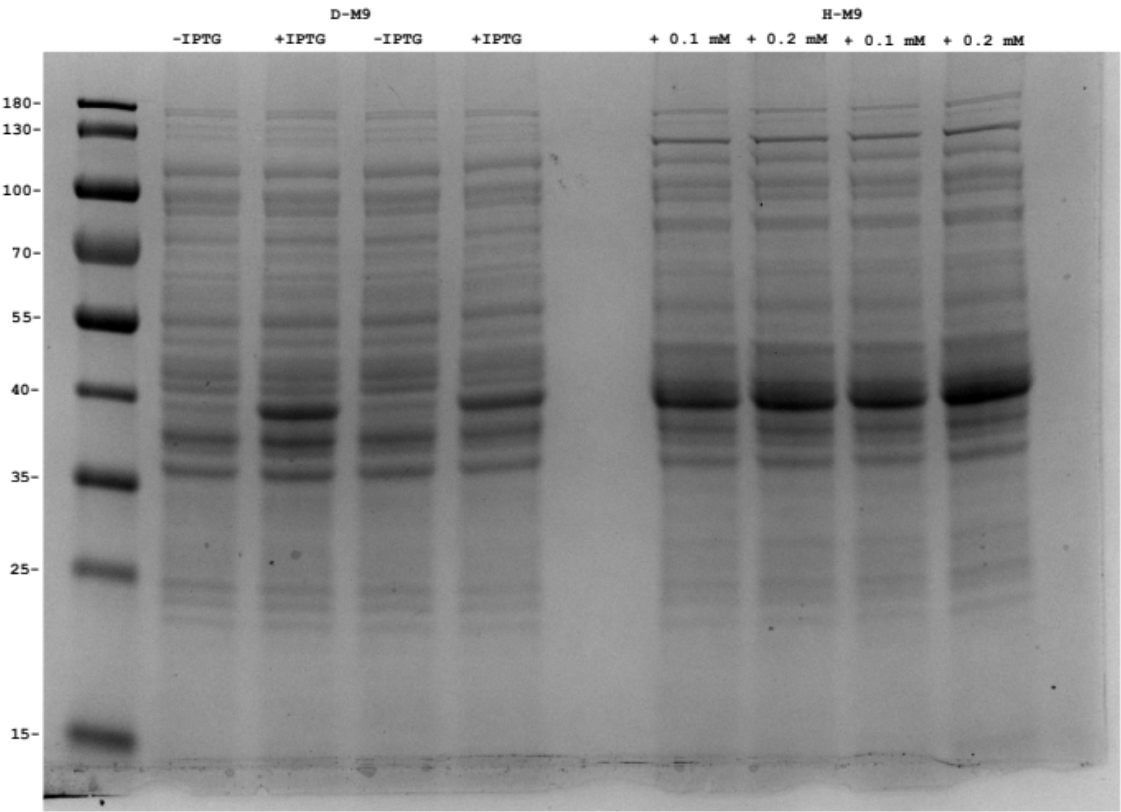
Figure 5. SDS-PAGE analysis of OmpF production. Whole cell fraction of E. coli DAP1(DE3) ( ∆ ompF ) expressing ompF cultured at 37 ◦ C in D-M9 and H-M9. Two different concentrations (0.1 or 0.2 mM) of the inducer IPTG was used in H-M9 media. For the D-M9 media 0.1 mM IPTG was used. The culture grown in H-M9 was induced at an OD600 of 0.5 and the D-M9 culture at 1.5. Cells were harvested 8 (H-M9) and 15 (D-M9) hours after induction. Each condition was done with two biological replicates and the samples were loaded at cultured volume equivalents. The right lane was loaded with a molecular size marker ladder (kDa). Recombinant OmpF has a predicted mass of 39.5 kDa.